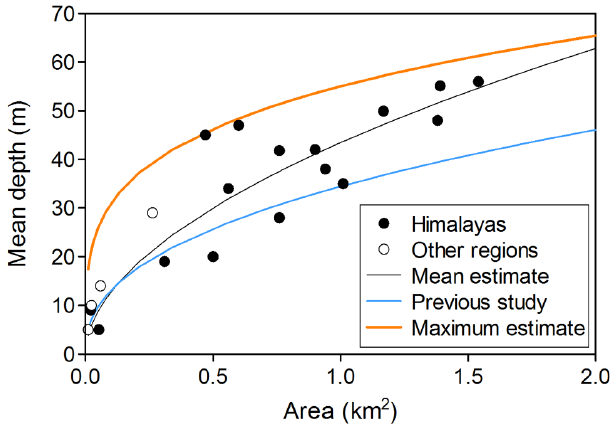
Fig. 2. Observational relationship between lake area and mean depth of Himalayan glacial lakes (solid dots). Open dots are moraine-dammed lakes in other regions of the world (Clague and Evans, 2000; Huggel et al., 2002). Thin black, blue, and orange lines show an approximate curvilinear fit for the observational data, and for other glacial lakes worldwide (Huggel et al., 2002), and the maximum approximate curve used to constrain lake depth in this study,